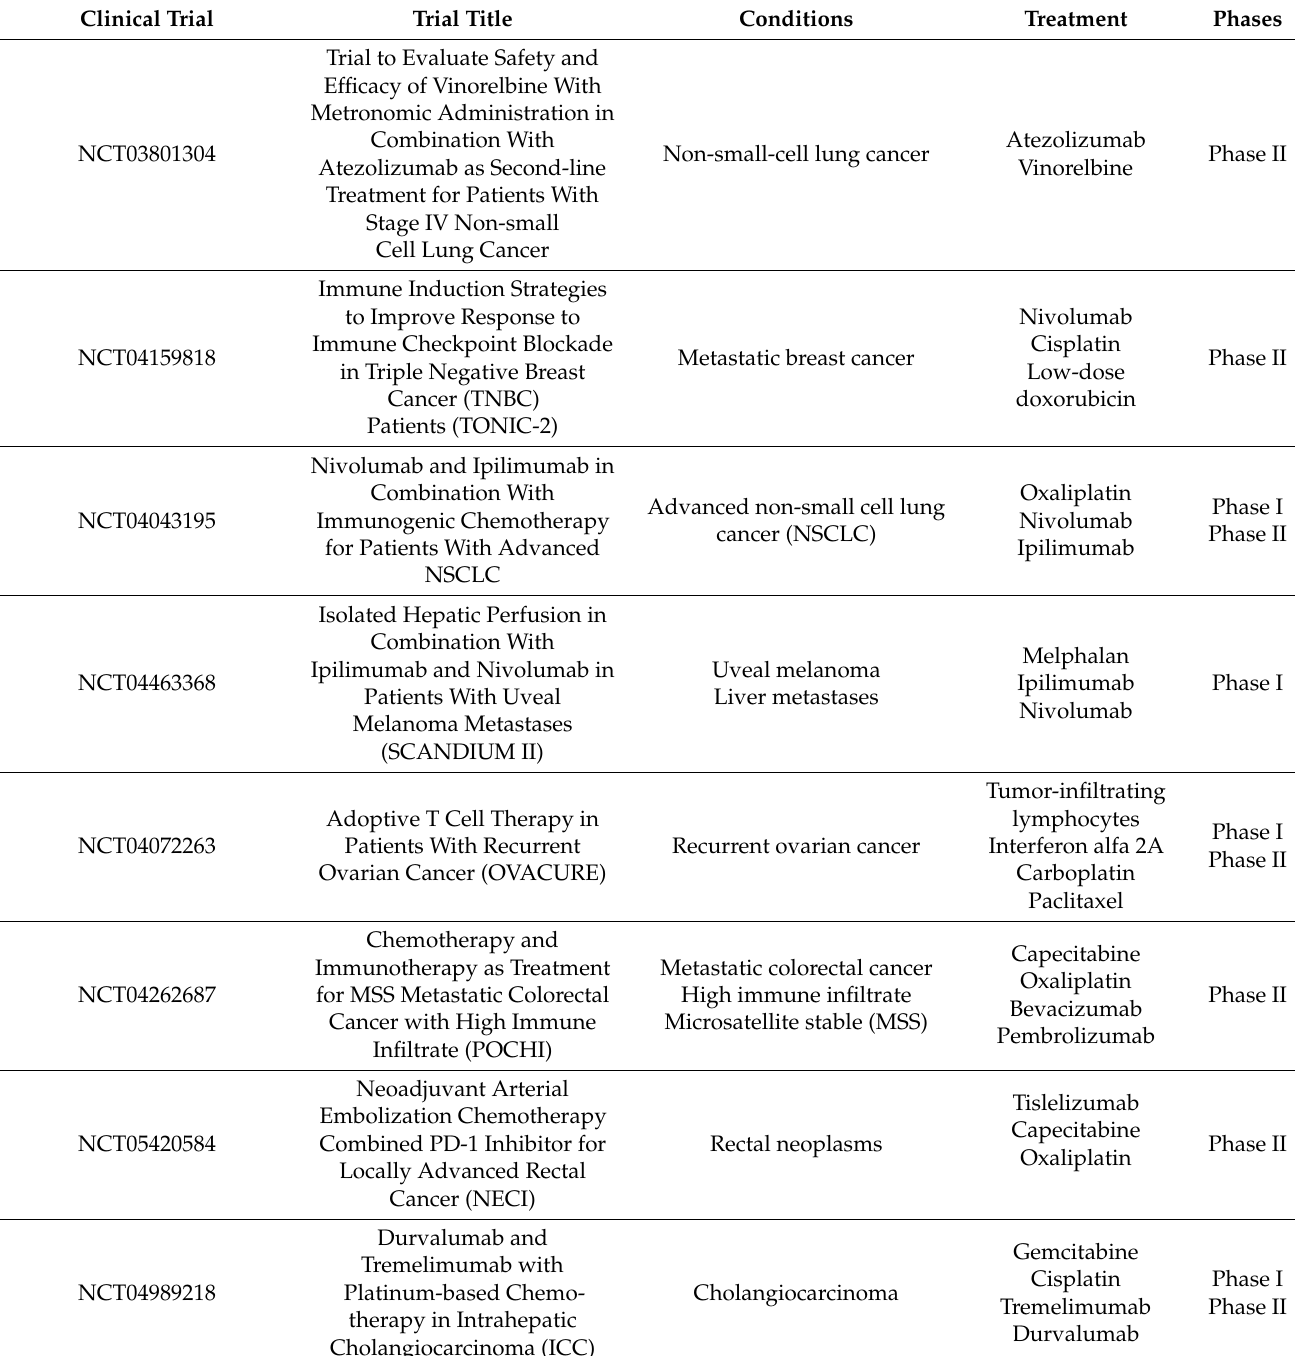
Table 1. Clinical trials investigating immunogenic cell stress mediated by